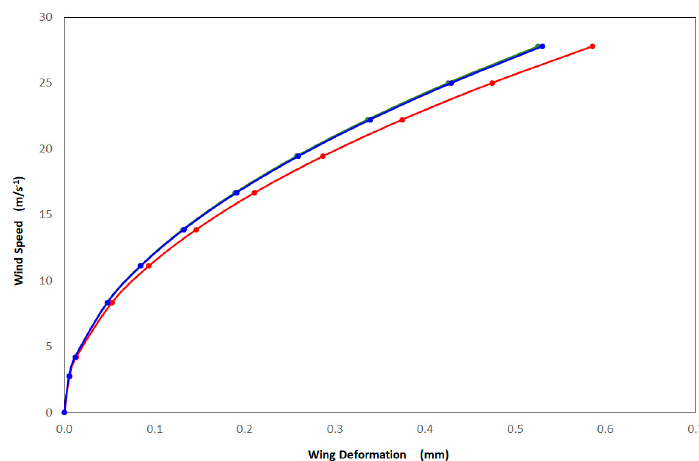
Figure 5. Finite element method-modelled maximum wing deformations (mm) versus wind speed (m / s − 1 ) of the three codling moth treatment populations: ecological (green); integrated (blue); and laboratory-reared (red).